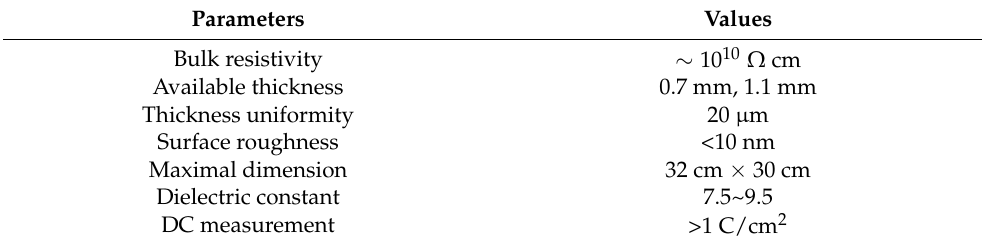
Table 2. The parameters of low resistive